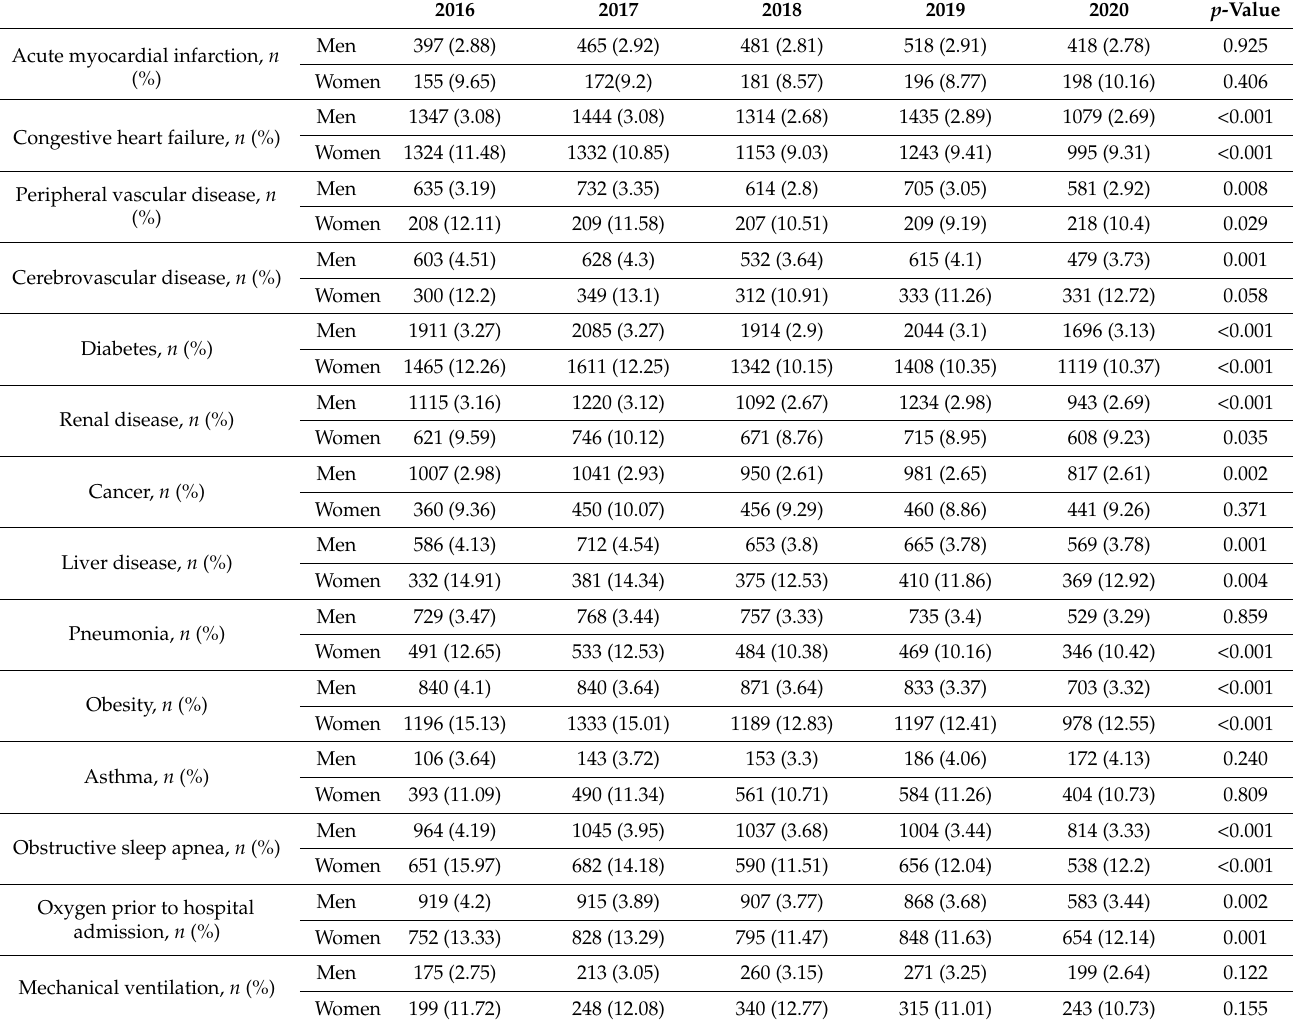
Table 3. Prevalence of depression among men and women hospitalized with COPD in Spain 2016– 2020, according to selected concomitant